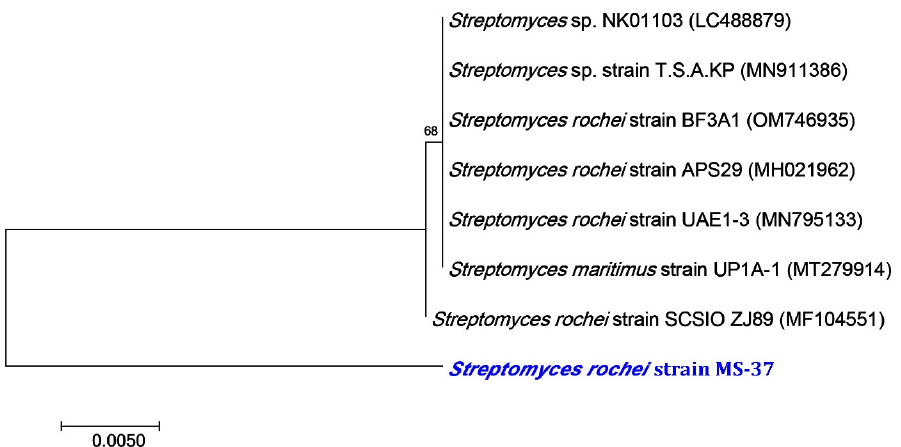
Figure 2. A neighbor-joining tree of Streptomyces rochei MS-37 with its closely related taxa. The bootstrap consensus tree inferred from 1000 replicates represents the evolutionary history of the taxa analyzed. The scale bar indicates 0.005 substitutions per nucleotide position.